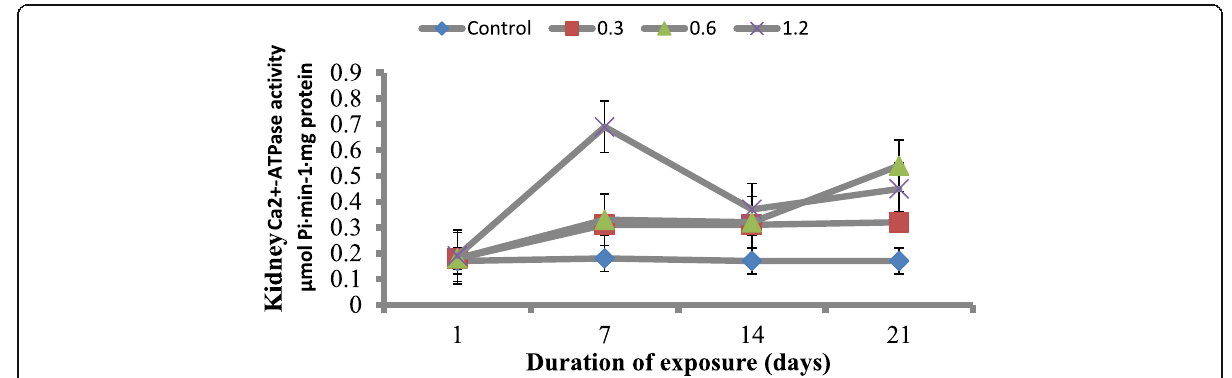
Fig. 2 Changes in the kidney Ca 2+ -ATPase activity in Clarias gariepinus juvenile exposed to oxadiazon (mean ± SD)